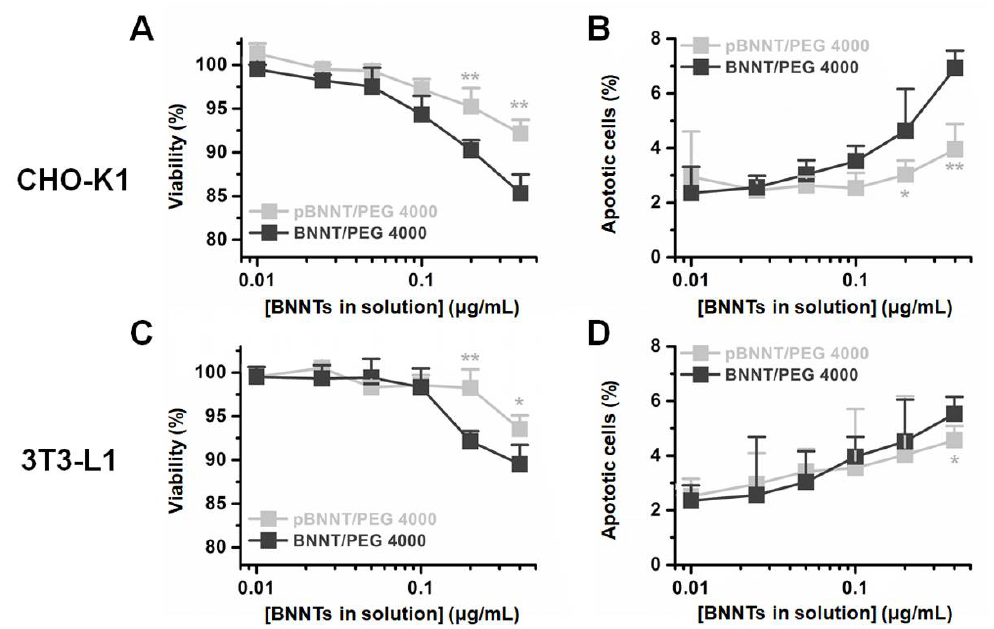
Figure 4 . Water dispersed BNNT/PEG 4000- and pBNNT/PEG 4000-induced cytotoxicity in ( A ) CHO-K1 and ( C ) 3T3-L1 cells. Percentages of apoptotic ( B ) CHO-K1 and ( D ) 3T3-L1 cells after incubation with BNNTs and pBNNTs. Error bars represent the standard deviation of tee replicates. * for p < 0.05, ** for p < 0.01.